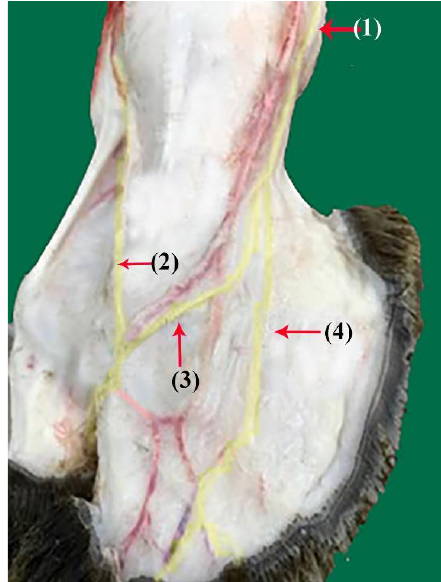
Figure 5. Nerve supply of the dorsal and plantar surfaces of the phalanx of the hindlimb in camels: (1) lateral plantar nerve (common plantar digital nerve of the IV digit); (2) axial dorsal proper digital IV nerve; (3) abaxial dorsal proper digital IV nerve; (4) abaxial plantar proper digital IV nerve. 3.2. Tibial Nerve ( N. tibialis)